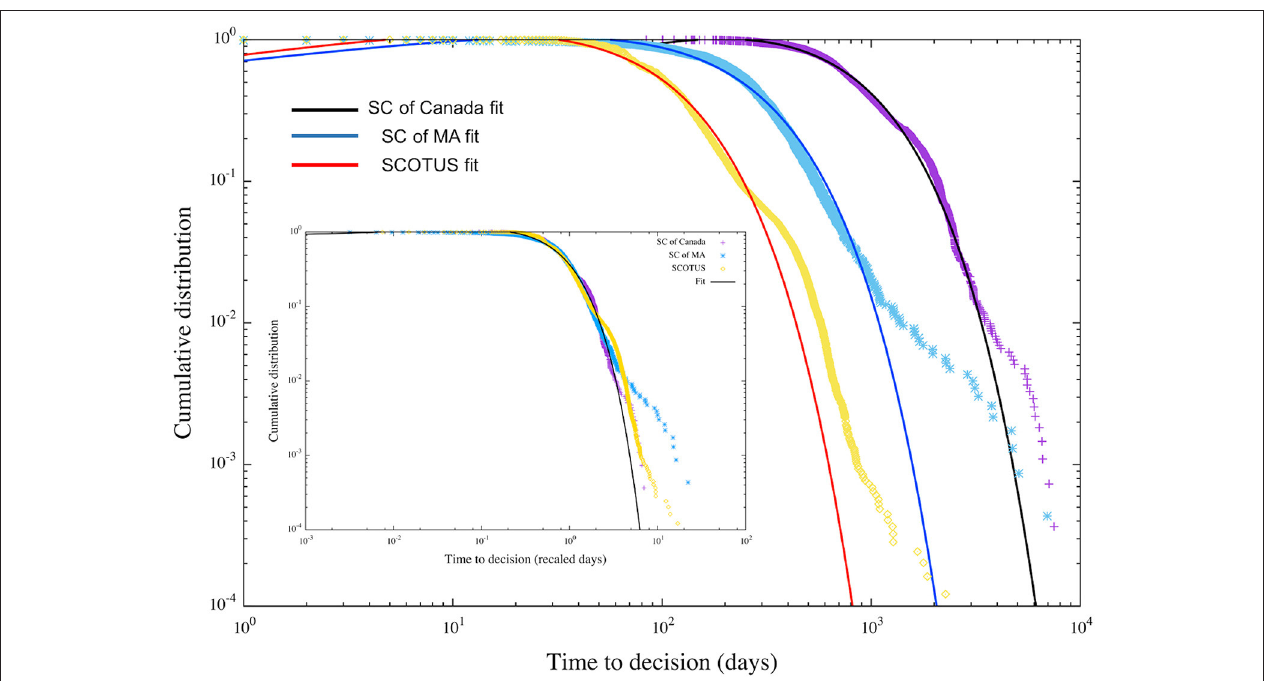
FIGURE 1 | Probability distributions of time to decision for different courts. The distribution is plotted for the time to decision in the SCOTUS, the Supreme court of Canada, and the Supreme Court of Massachusetts. The inset shows the fit of the distribution of the rescaled data. The data are fitted by the functional form P ( x ) ∝ ( x a + b )e − x / c . We present ( a, b, c ), the parameters of the fit in Table 2 .